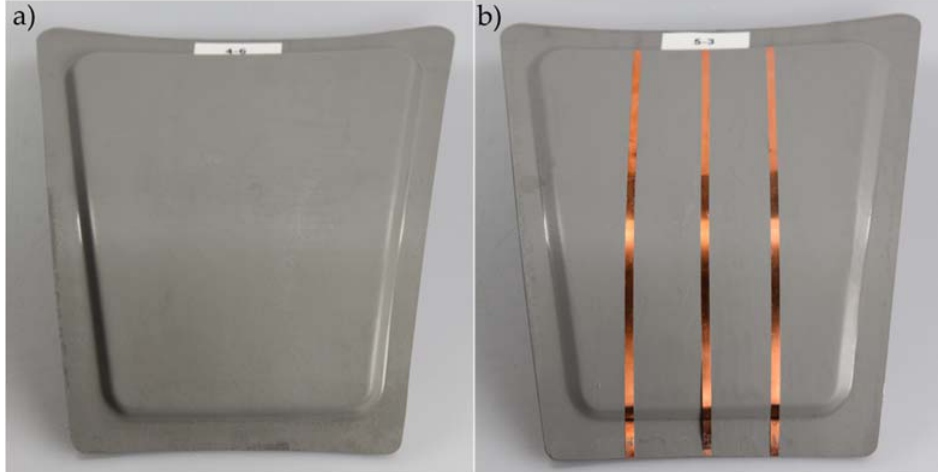
Figure 6. Formed hybrid laminates with sensor functionality in two versions: ( a ) without electrodes and ( b ) with electrodes at preheating temperature 180 °C and tool temperature 150 °C.